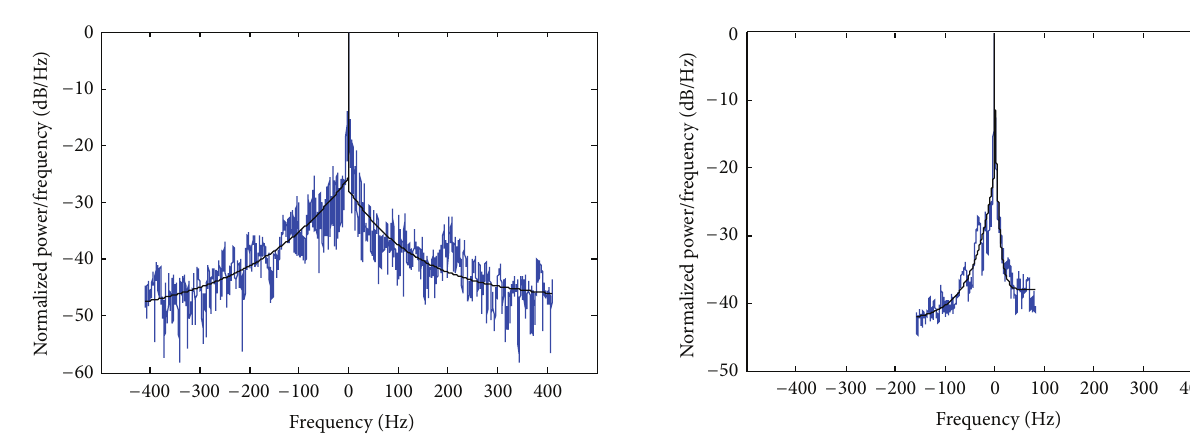
Figure 12: Example D: estimated PSD and corresponding exponen- tial fitting ( 𝑎 = 21.72 , 𝑏 = 2.29 ⋅ 10 −2 , 𝑐 = 42.64 , 𝑑 = 31.74 , 𝑒 = 1.16 ⋅ 10 −2 , 𝑔 = 37.99 , 󳵻𝑓 = 241.12 , and 𝛾 = 0.31 ).